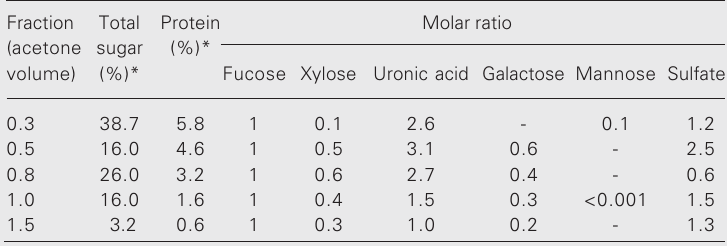
Table 1. Partial chemical composition of acidic polysaccharides obtained from Padina gymnospora by acetone precipitation . Fraction Total Protein